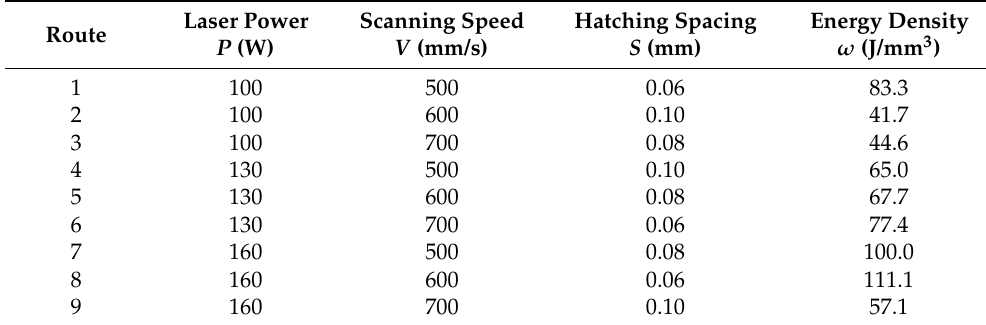
Table 2. Orthogonal parameter design.